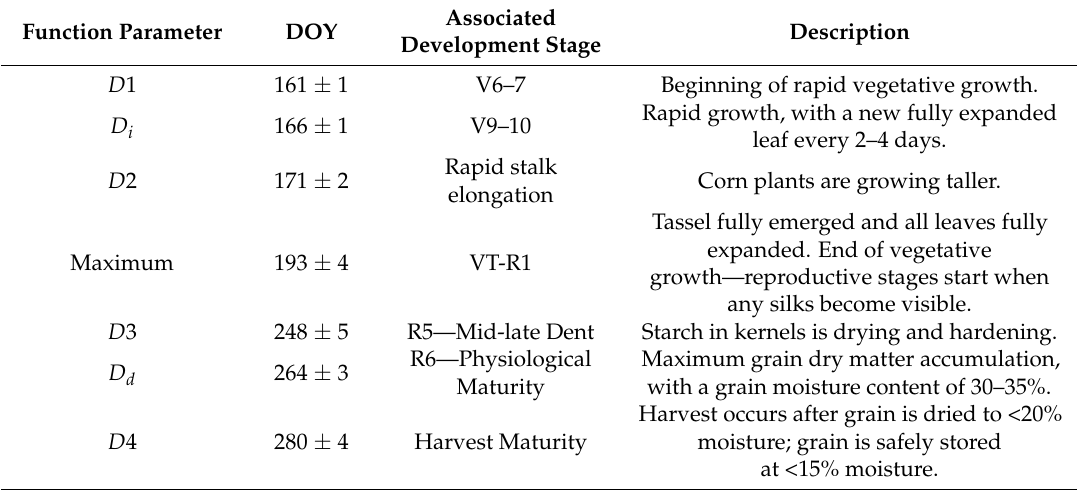
Figure 4. Four different plot-average NDVI time-series fit to the asymmetric double sigmoid function. Plot 63 was non-irrigated and treated with 200% N, Plot 94 was non-irrigated and treated with 0% N, Plot 82 was irrigated and treated with 50% N, and Plot 24 was irrigated and treated with 75% N. Table 4. Average values of D 1, D i , D 2, D 3, D d , and D 4 across all plots, with standard deviations included, related to field-measured corn growth stages when applicable. Descriptions of corn growth stages are taken from [33]. Although it was not considered in the resampling analysis, the location of the function maximum was shown to occur at the same time as the corn plant